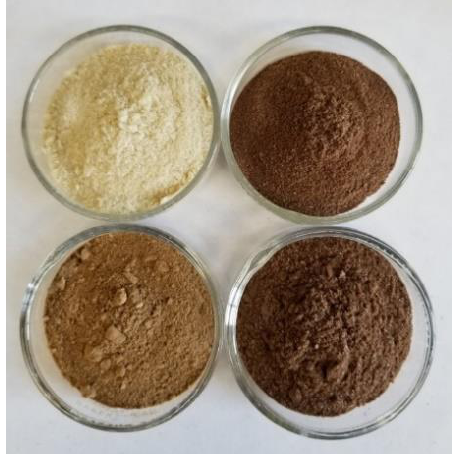
Figure 2 . Protein isolate extracted from hemp seeds and hemp by-products. Clockwise from top left: protein isolate from hemp hearts, hemp whole seed, hemp hulls, and hemp cake. protein isolate from hemp hearts, hemp whole seed, hemp hulls, and hemp